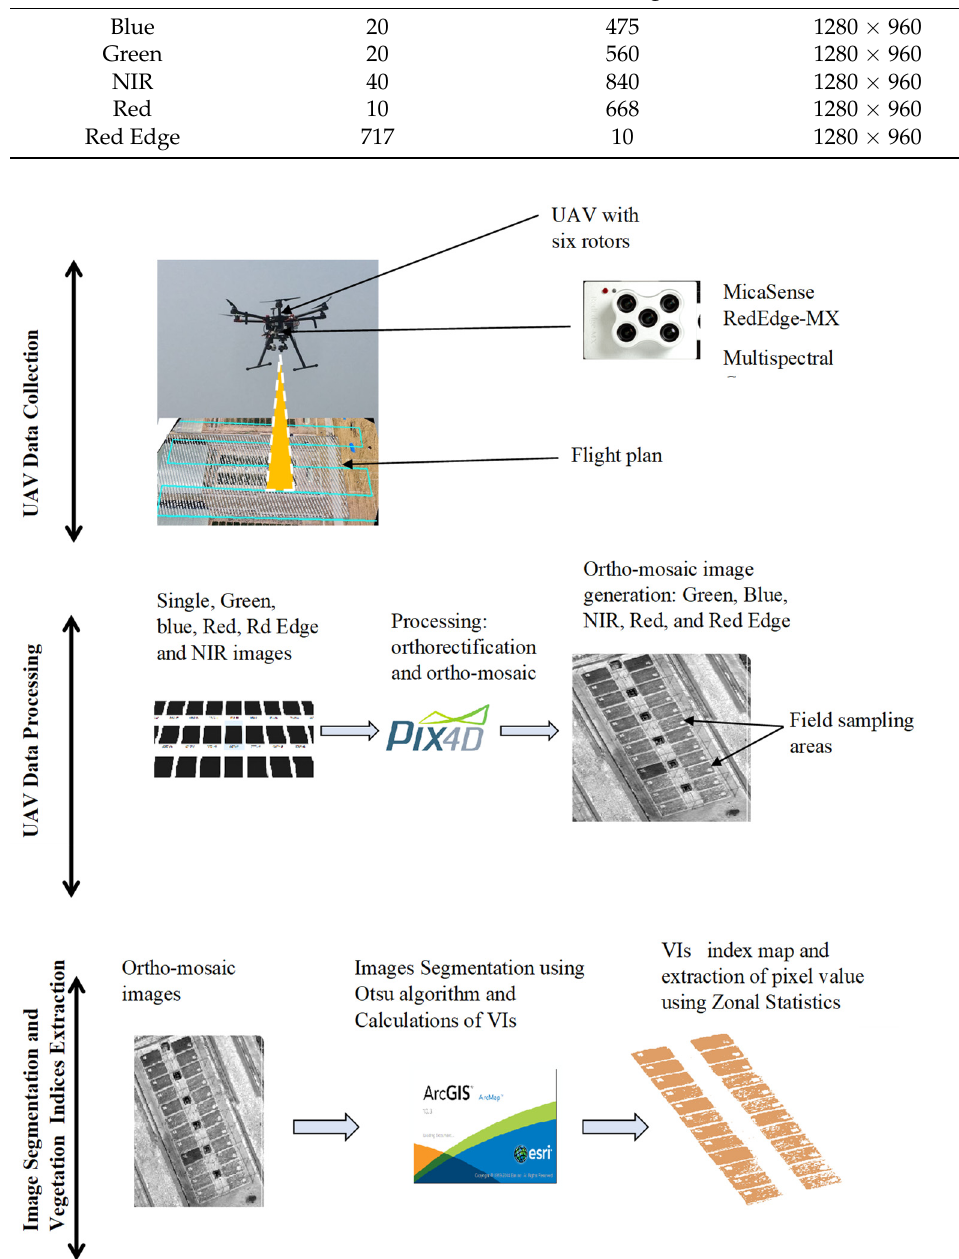
Figure 2. An example of UAV data acquisition, processing, and canopy feature extraction workflow.